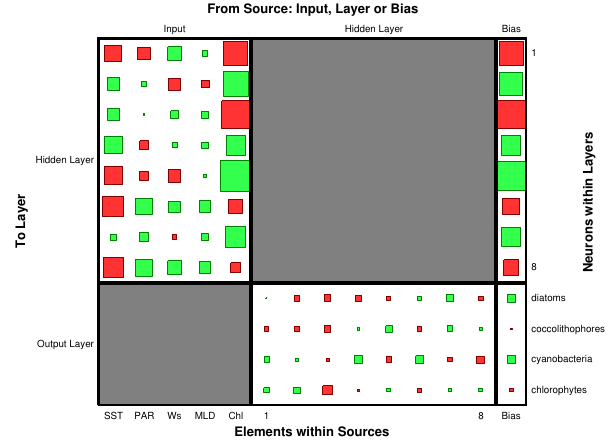
Fig. 5. Hinton-weight diagram depicting relative weights assigned to all connections within 1 of 10 PhytoANNs used to create the en- semble. Green corresponds to positive correlation, red to negative correlation. The area of the square is proportional to the strength of correlation. The left-hand side illustrates the connection weights between the input and the hidden layer. The right-hand side illus- trates the connection weights between the hidden layer and the out- put layer.